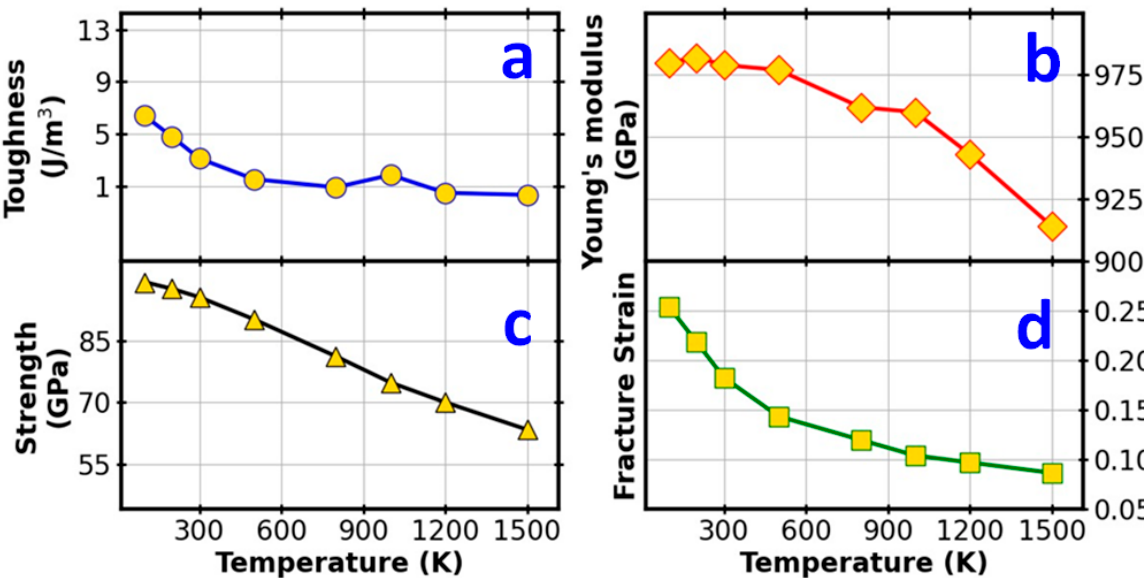
Figure 8. Temperature dependence of defective SLGSs’ mechanical properties, including: ( a ) toughness, ( b ) Young’s modulus, ( c ) fracture strength, and ( d ) fracture strain. The tensile simulations were carried out under the following conditions: The strain rate was 10 9 s − 1 . The pressure was 0.0001 GPa (1 atm). The model I loading was applied along the x axis (armchair direction). The system size was 4 × 4 (or 20.7 nm × 20.5 nm with 16,128 lattice sites). All the systems had a pre-crack in the shape of an isosceles right triangle.